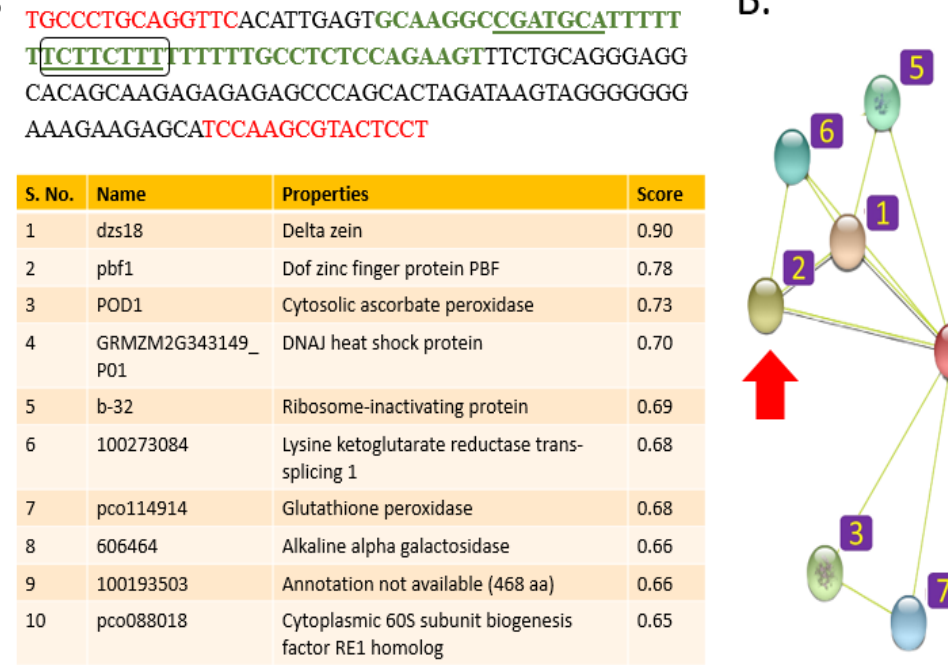
Figure 1. phi112 marked DNA and opaque2 functional associations. ( A ). ph112 marked DNA. The primer sequences are shown in red. The discovered motifs are underlined. The motif discovery associated with transcription factor activity is boxed. The green region marks the DNA sequence used to perform protein–DNA interaction analysis. ( B ). Functional associations of opaque2 protein (numbers denote proteins mentioned in the Table). PBF1 transcription factor is marked with an arrow. ( C ). List of interacting proteins with the score indicating the association’s likelihood.